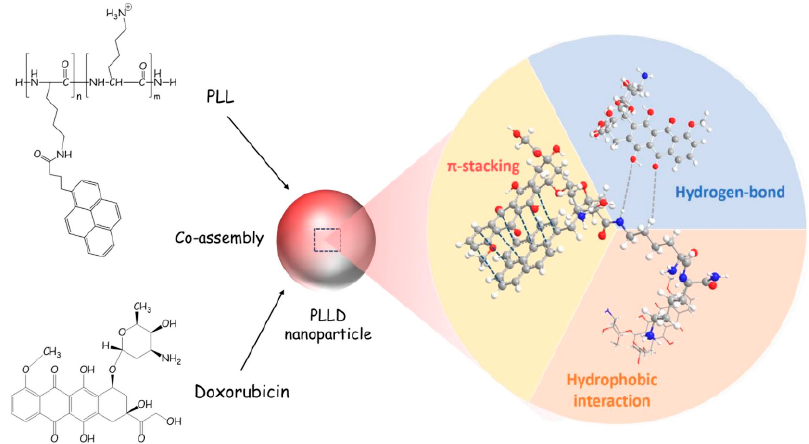
Figure 15. Schematic figure of cooperative self-assembly of PLL and therapeutics (Reproduced with the permission from Ref. [94]). Table 2. Photophysical properties and imaging applications of important pyrene conjugates.